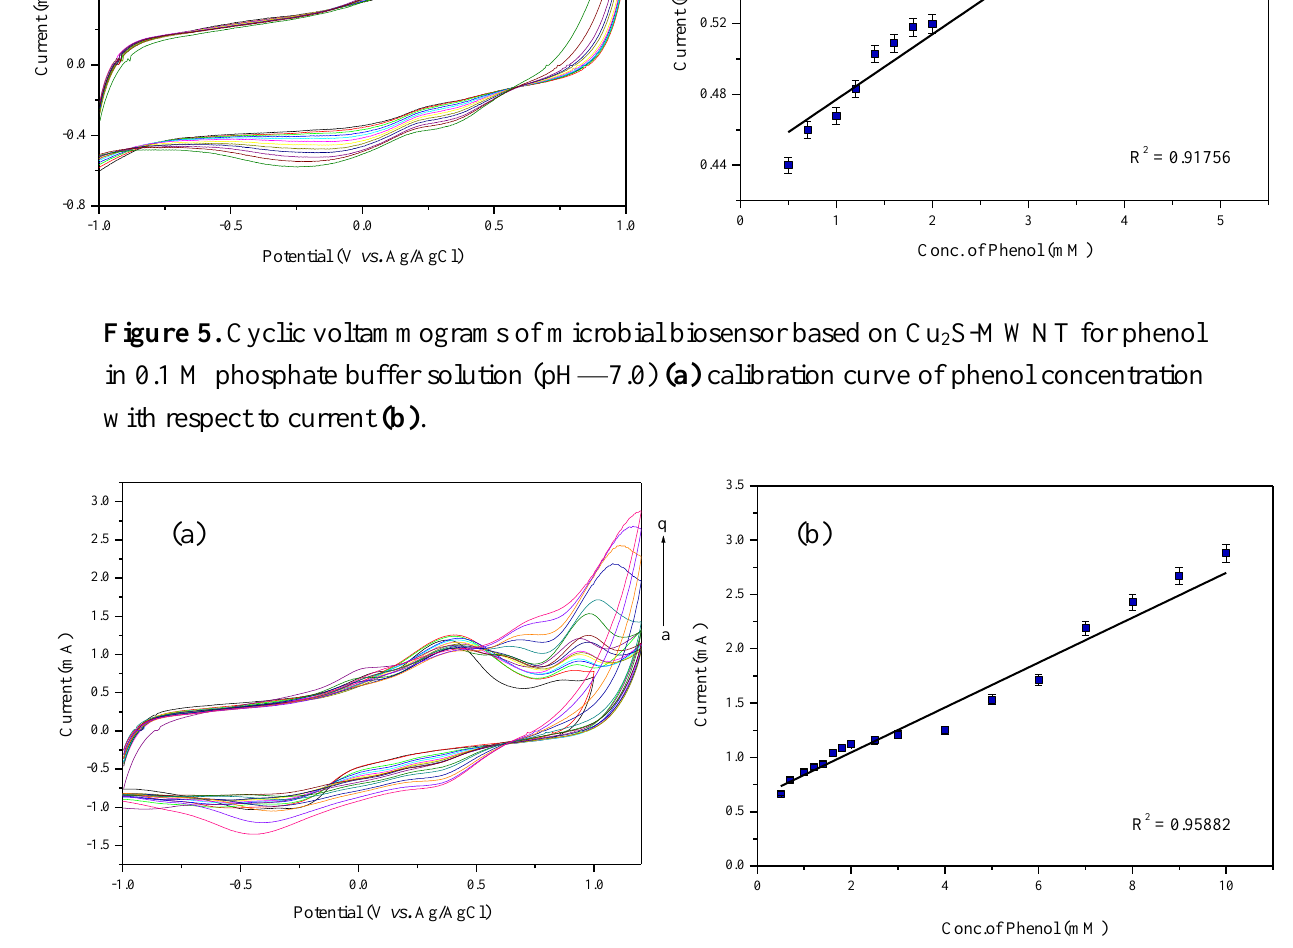
Figure 4. Cyclic voltammograms of the microbial biosensor based on CdS-MWNT for phenol in 0.1 M phosphate buffer solution (pH—7.0) (a) calibration curve of phenol concentration with respect to the current (b) .